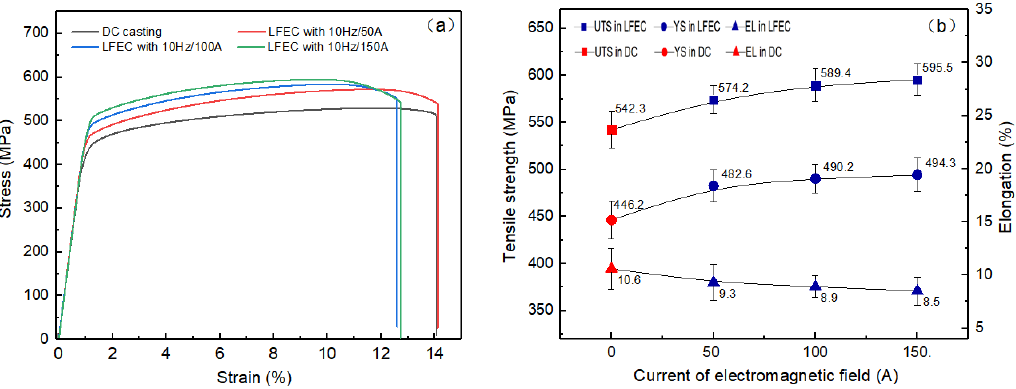
Figure 12. Engineering stress-strain curves and tensile properties of 2A97 aged alloy cast in different electromagnetic field conditions.